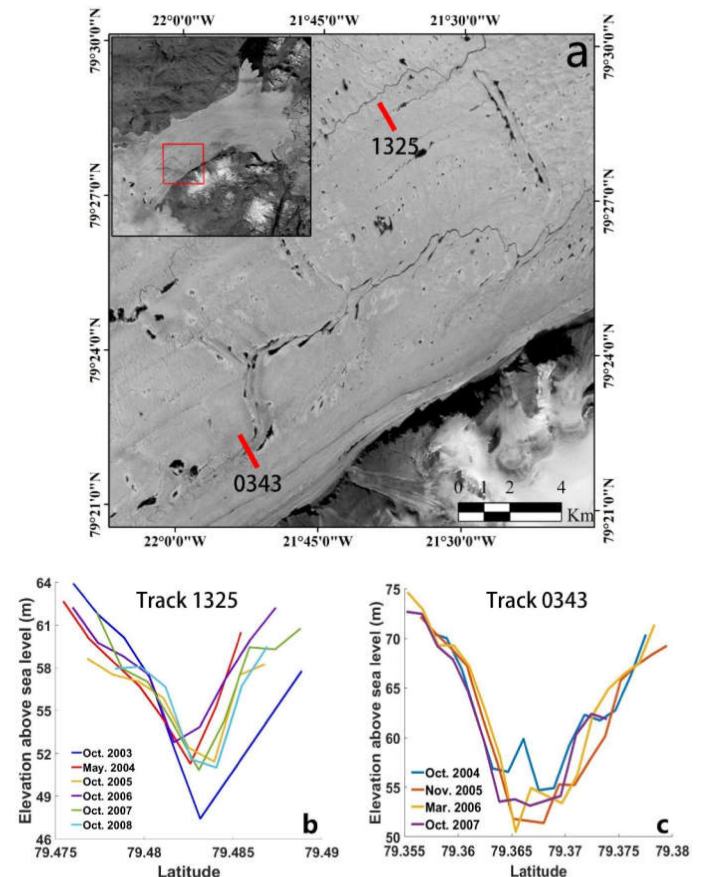
Figure 6. An example of a depression on the 79NG ice shelf verified by ICESat. ( a ) Depression distribution on the surface of 79NG ice shelf. The solid red line indicates ICESat satellite orbit. ( b ) and ( c ) represent the ICESat data track 1325 and track 0343